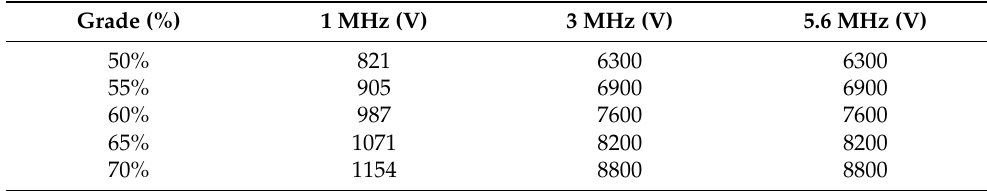
Table 1. The voltages of